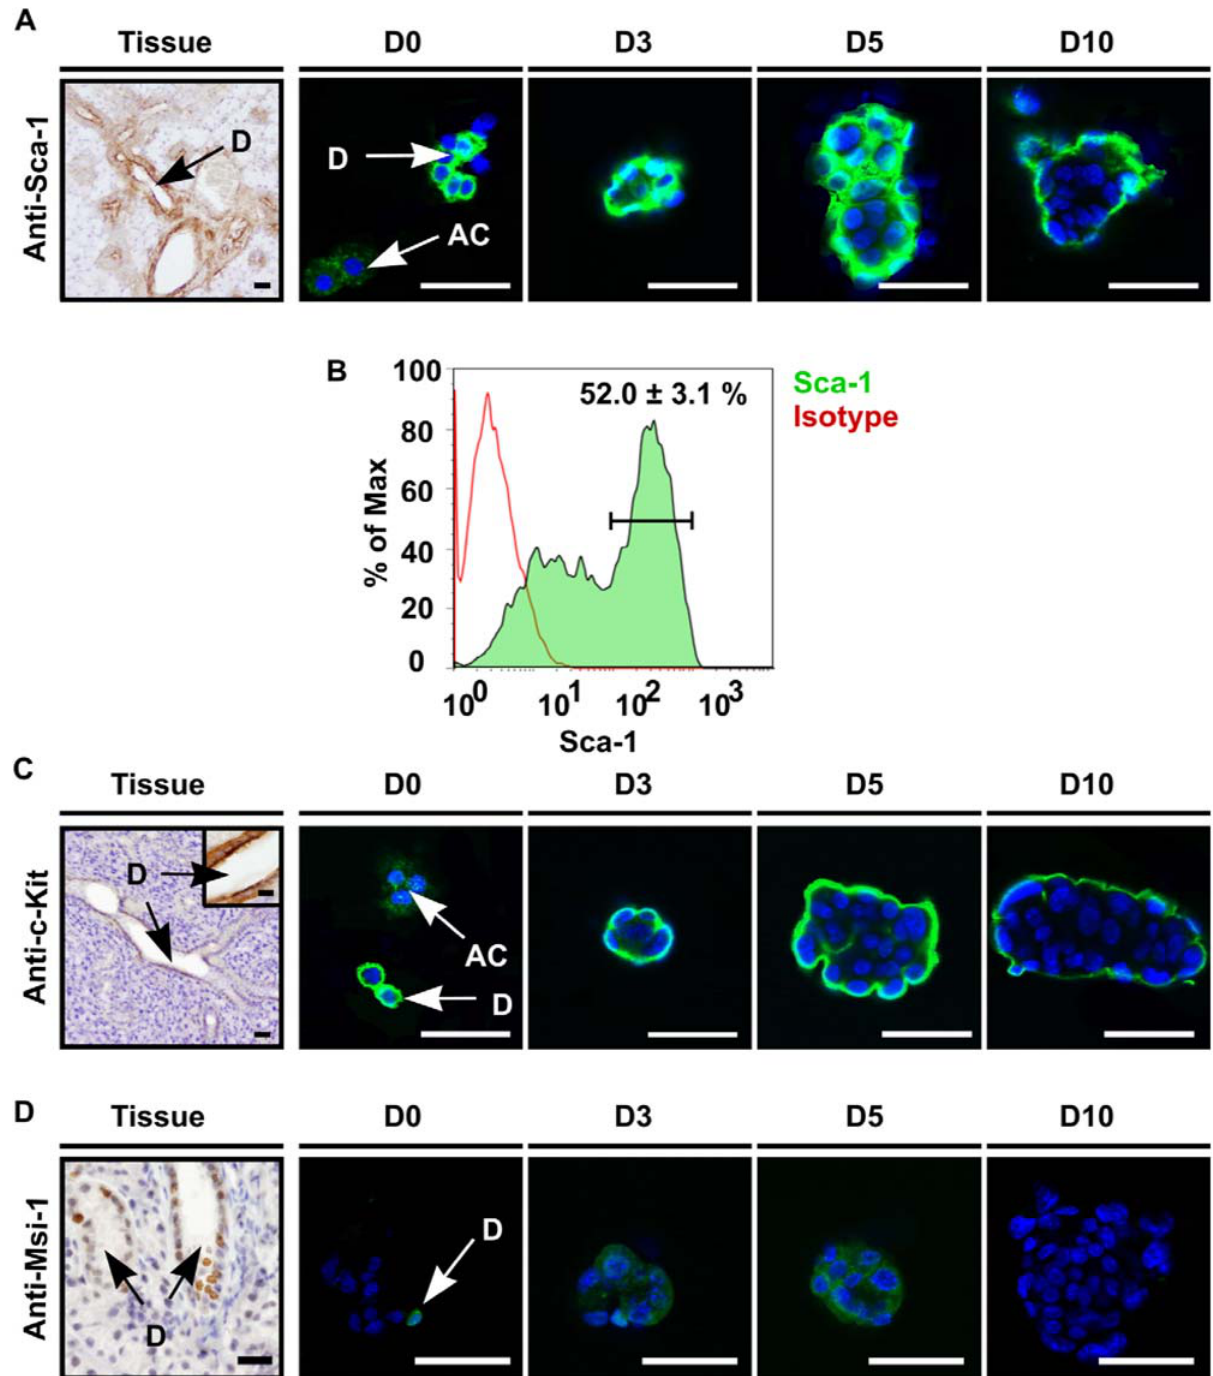
Figure 4. Salispheres contain stem cells. (A) Sca-1 is present in the mouse submandibular gland on endothelial cells as well as on excretory and striated duct cells (D), and was clearly present at the onset of cultivation (D0) whereas acinar cells (AC) did not express Sca-1. At day 3 and later time- points, nearly all cells at the periphery of the salispheres showed high Sca-1 expression which decreased in time (D10). (B) Approximately 52.0 + / 2 3.1% (Mean + / 2 STDEV) of cells in D3 cultured spheres expressed Sca-1, as quantified by flow cytometry. (C) c-Kit is only expressed by excretory duct cells (Tissue). Salispheres showed similar c-Kit staining patterns as for Sca-1. (D) Most nuclei in excretory duct compartments and few nuclei in striated duct cells showed Musashi-1 presence (Tissue). Whereas Musashi-1 was still present in the nuclei of some cells at the onset of culturing (D0-arrow), most cells showed cytoplasmic localization which diminished in time (D3–5–10). Cells were visualized with DAPI (blue). Scale bar=50 m m, inset=20 m m. D=duct cells, AC=acinar cell, D0–3–5–10 represent days in culture.